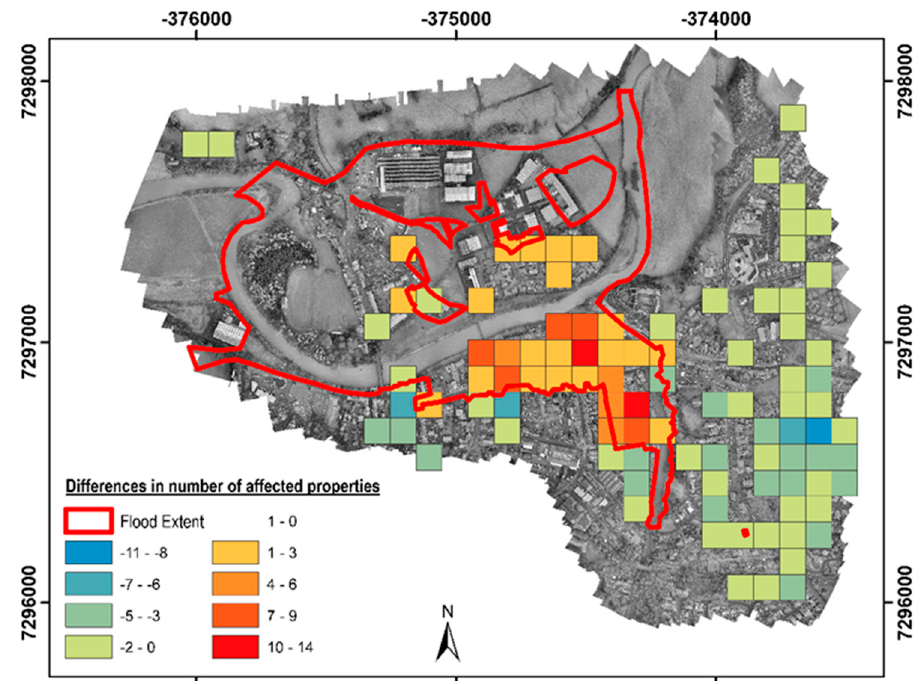
Figure 6. Differences between the classic and the UAV loss adjustment approaches in the number of residential properties in Cockermouth affected by flooding after Desmond (5–6 December 2015). Negative values indicate a larger number of properties identified as affected by the UAV approach.